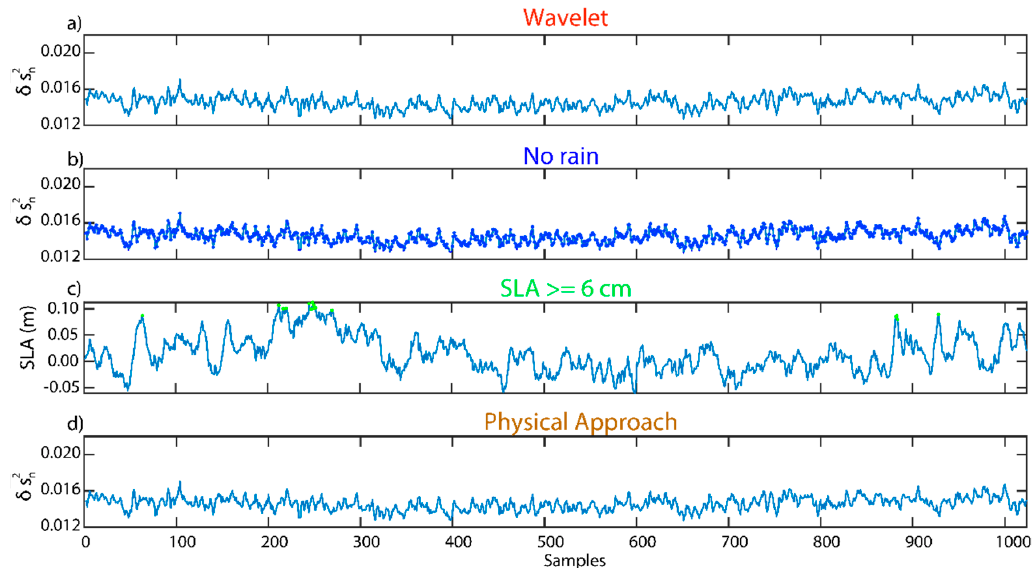
Figure 13. ( a ) Along-track SRAL record of δ s 2 n with wavelet analysis (no detections). ( b ) The same record with all cells passing the “no rain” criterion in this paper (dark blue). ( c ) The few SLA variations exceeding the threshold (6 cm) used in this paper (green dots) do not match any detections in the ( a ) wavelet or ( d ) physical approach criterion.